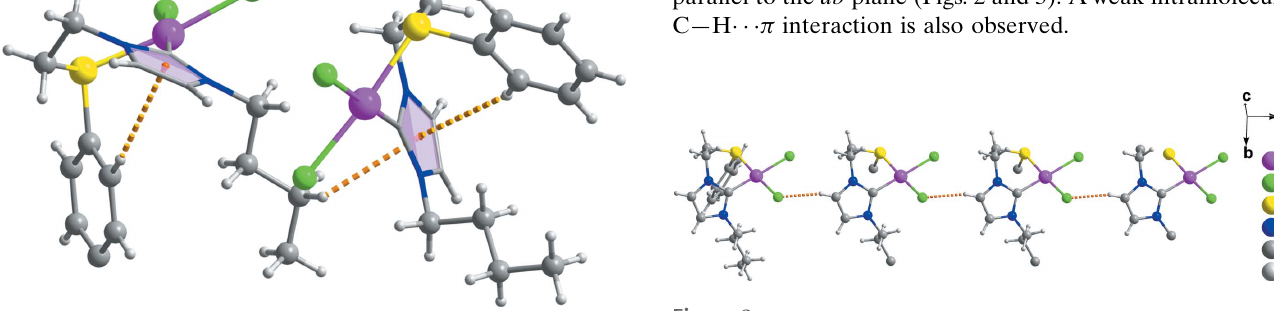
Figure 2 A packing diagram of the title compound, showing intra- and inter- molecular C—H (cid:2)(cid:2)(cid:2) (cid:2) interactions (dashed lines).